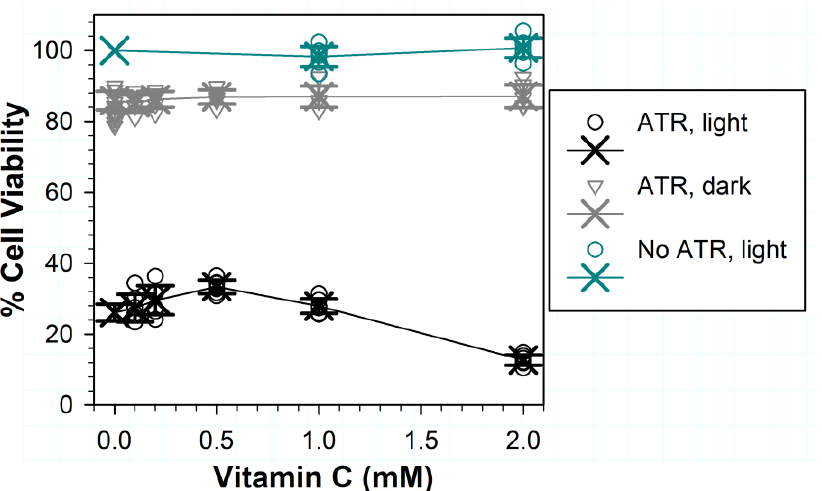
Figure 7. Effects on ARPE-19 cell viability of different concentrations of vitamin C for 1 h exposure to visible light (ATR, light) or incubation in the dark (ATR, dark) in the presence of liposomes containing 0.5 mM of ATR and 7 mg/mL of EYPC. Control cells in light-exposed plates were exposed to vitamin C and EYPC liposomes in the absence of ATR (No ATR, light). Cell viability was measured by MTT assay 24 h after the exposure. The symbols represent data from individual experiments, crosses represent the means, while the error bars represent SDs.